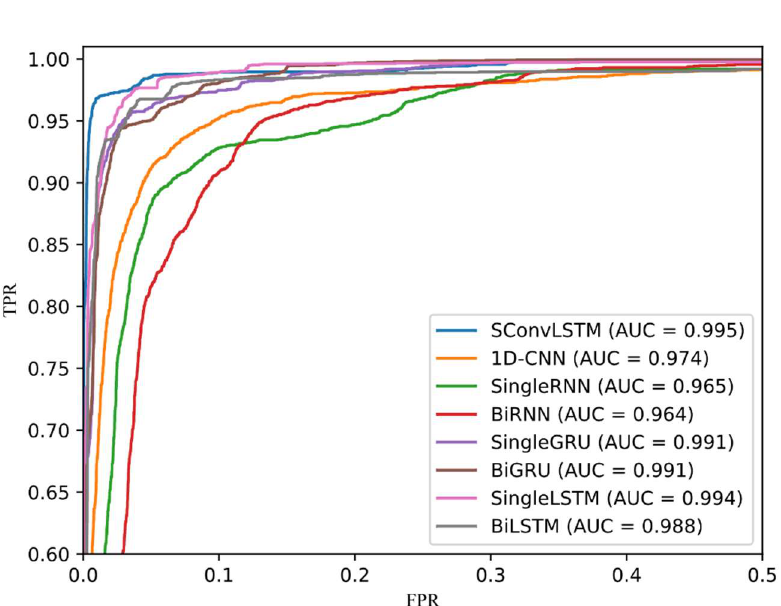
Figure 9. ROC curve of proposed method and some based on deep learning methods on UCI HAR dataset.